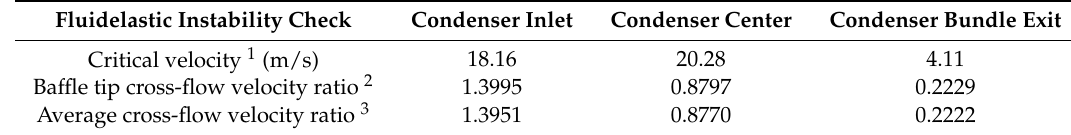
Table 10. High cross-flow velocity ratio in inlet and center section.